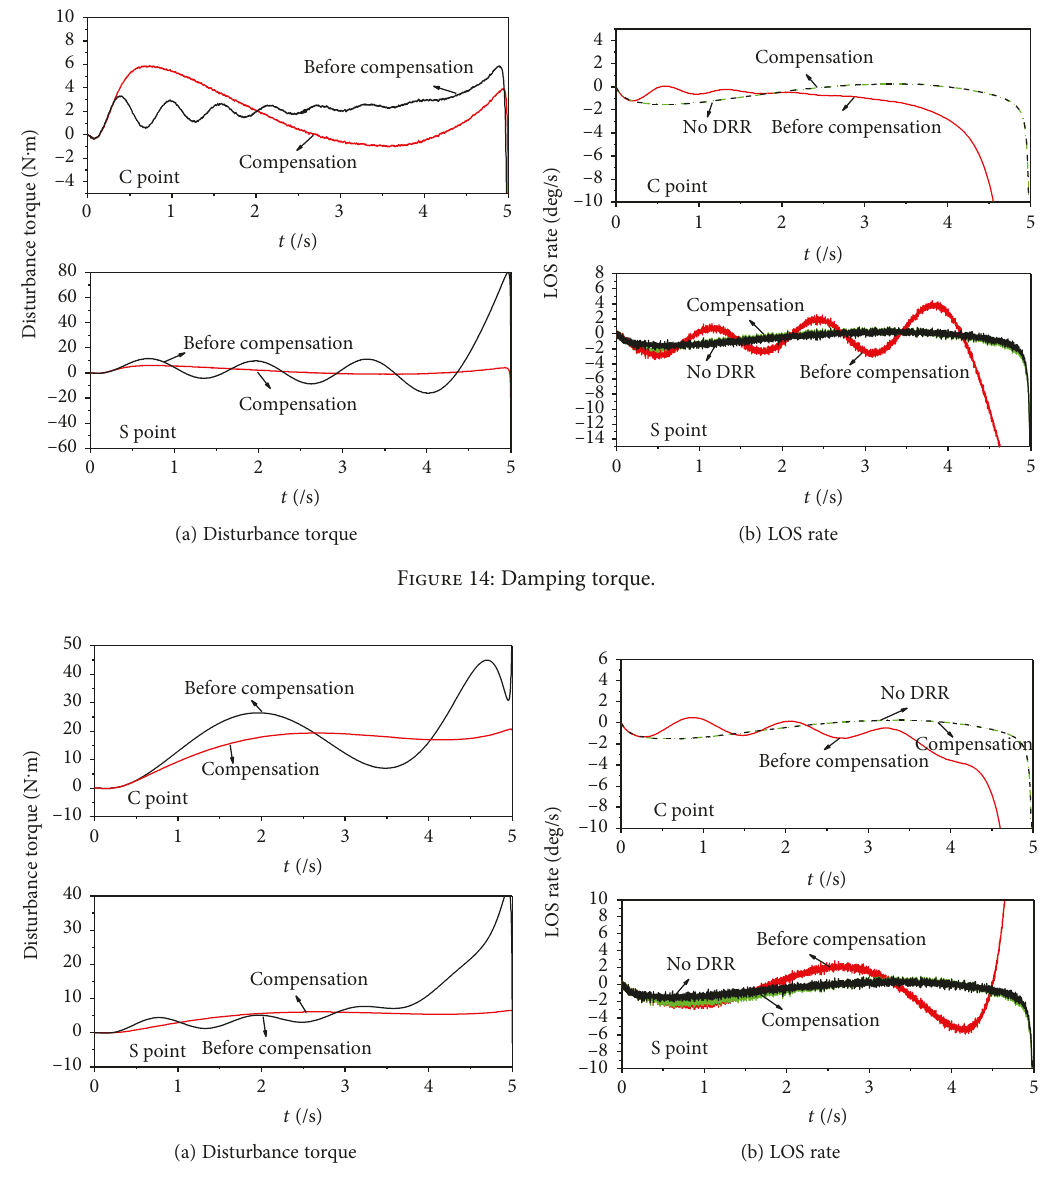
Figure 15: Spring torque.